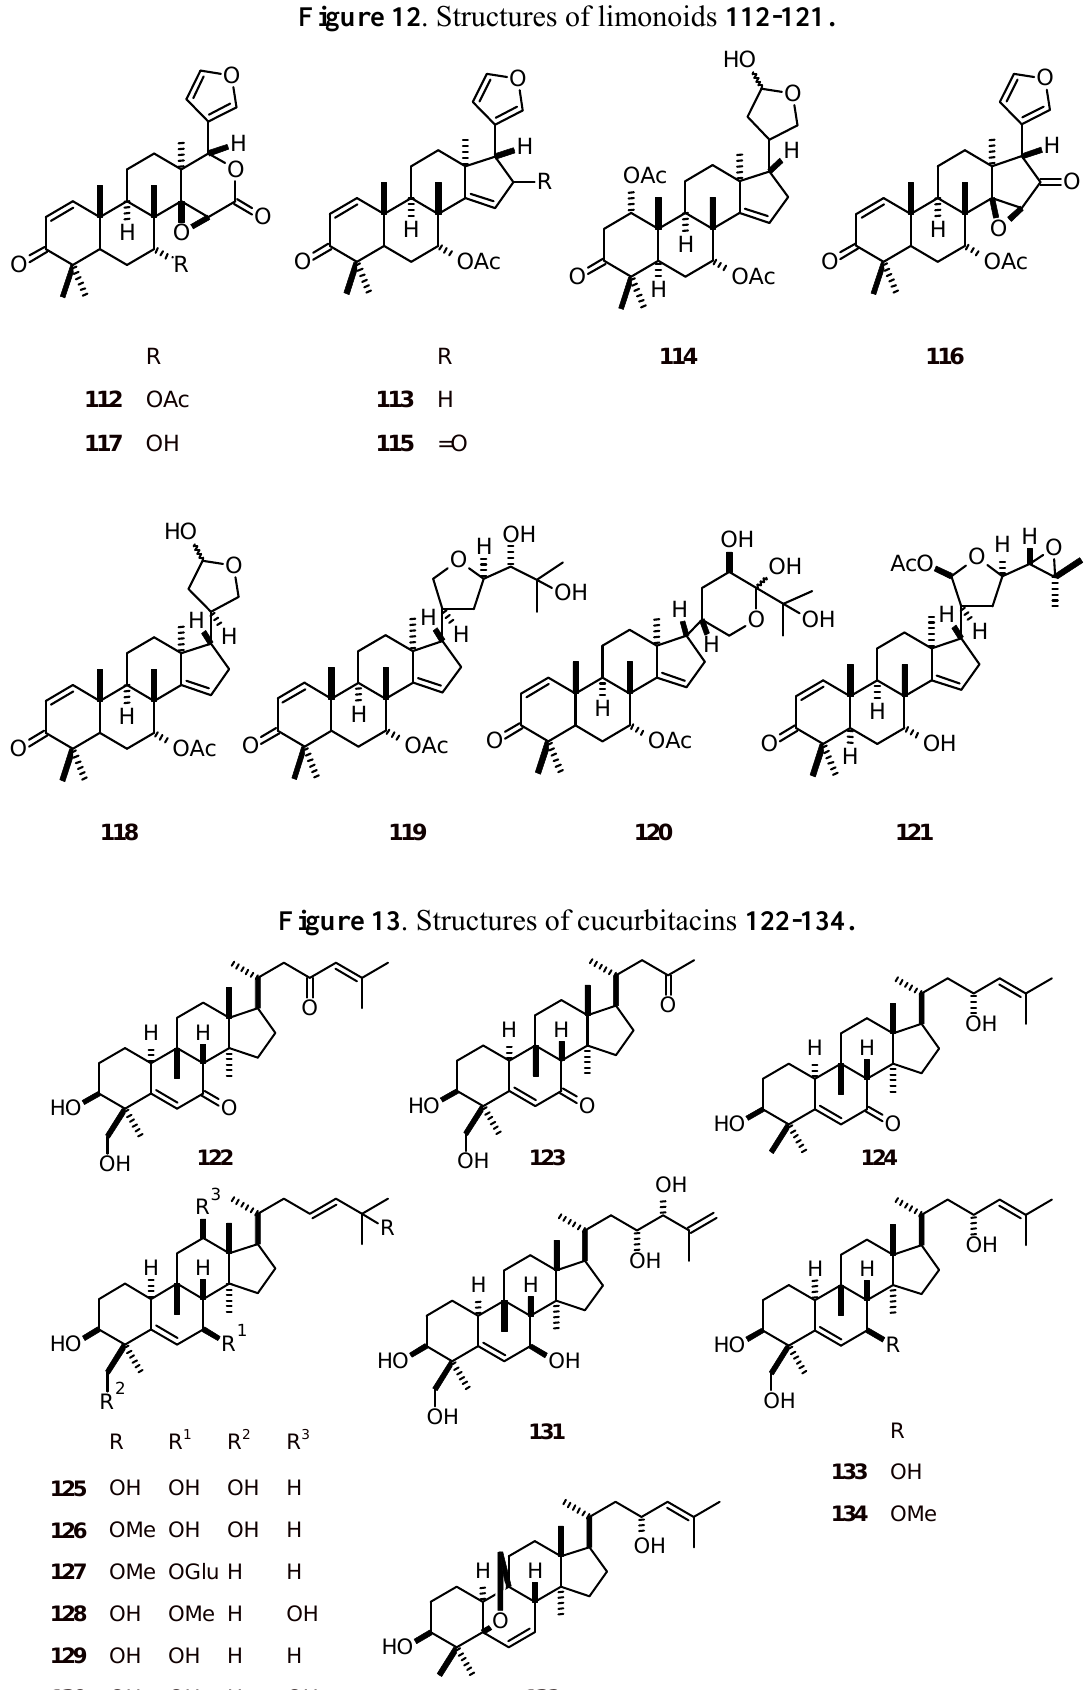
Figure 12 . Structures of limonoids 112-121.